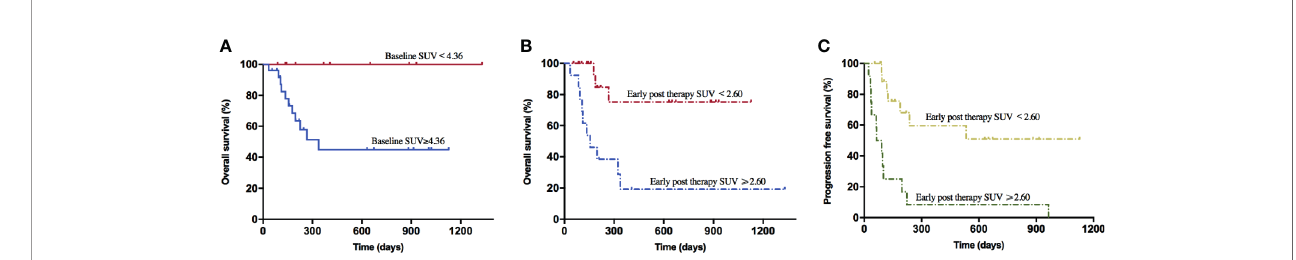
FIGURE 1 | Survival curves of lymphoma patients associated with baseline SUV and early post-therapy SUV. (A) The 1-year OS rate of the baseline SUV < 4.36 group (100.0%) was higher than the baseline SUV ≥ 4.36 group (56.0%) ( p = 0.019). (B) The 1-year OS rate of the early post-therapy SUV < 2.60 group (85.0%) was higher than the early post-therapy SUV ≥ 2.60 group (23.1%) ( p = 0.001). (C) The PFS rate of the early post-therapy SUV < 2.60 group (65.0%) was higher than the early post-therapy SUV ≥ 2.60 group (0.0%) ( p